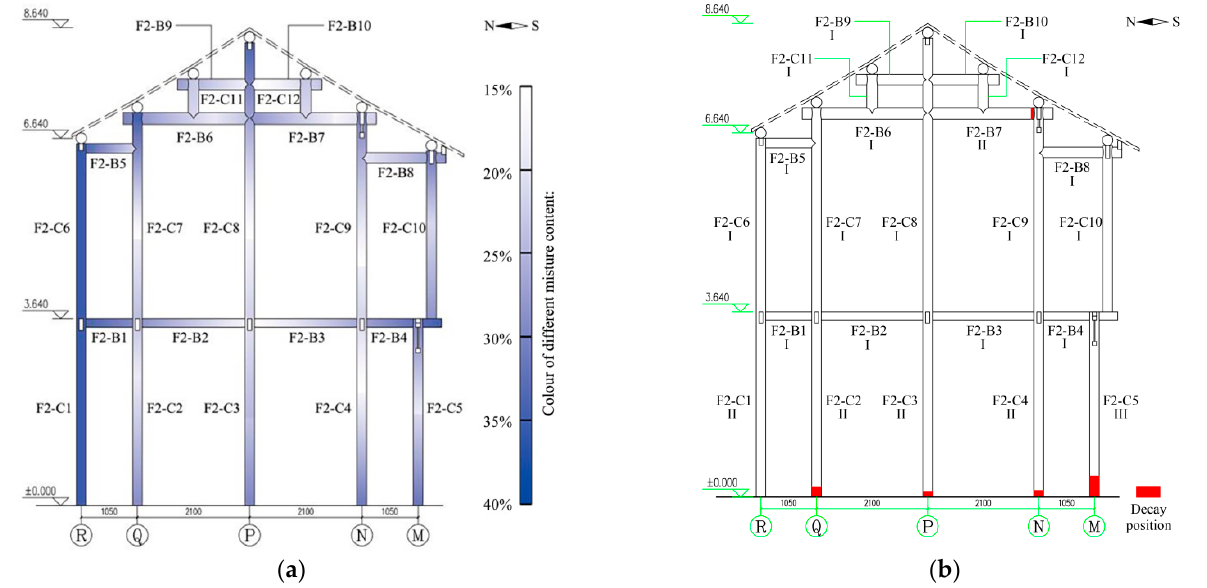
Figure 13. Moisture content and decay of F2 in Fujiu Zhou house; ( a ) schematic diagram of moisture content; ( b ) schematic diagram of decay position and decay grade.